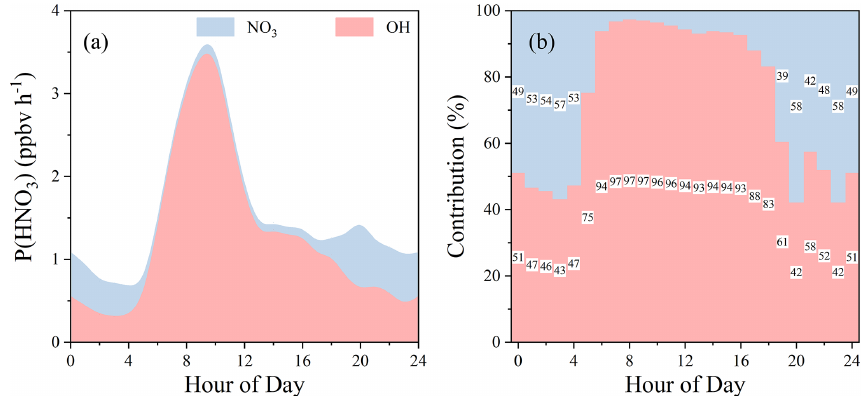
Figure 13. (a) HNO 3 production ( P (HNO 3 )) from NO 3 - or OH-induced reactions and (b) their relative contribution at each hour of the day. NO 3 -induced reactions include heterogeneous uptake of N 2 O 5 on the aerosol surface and all the other NO 3 reactions that produce HNO 3 .